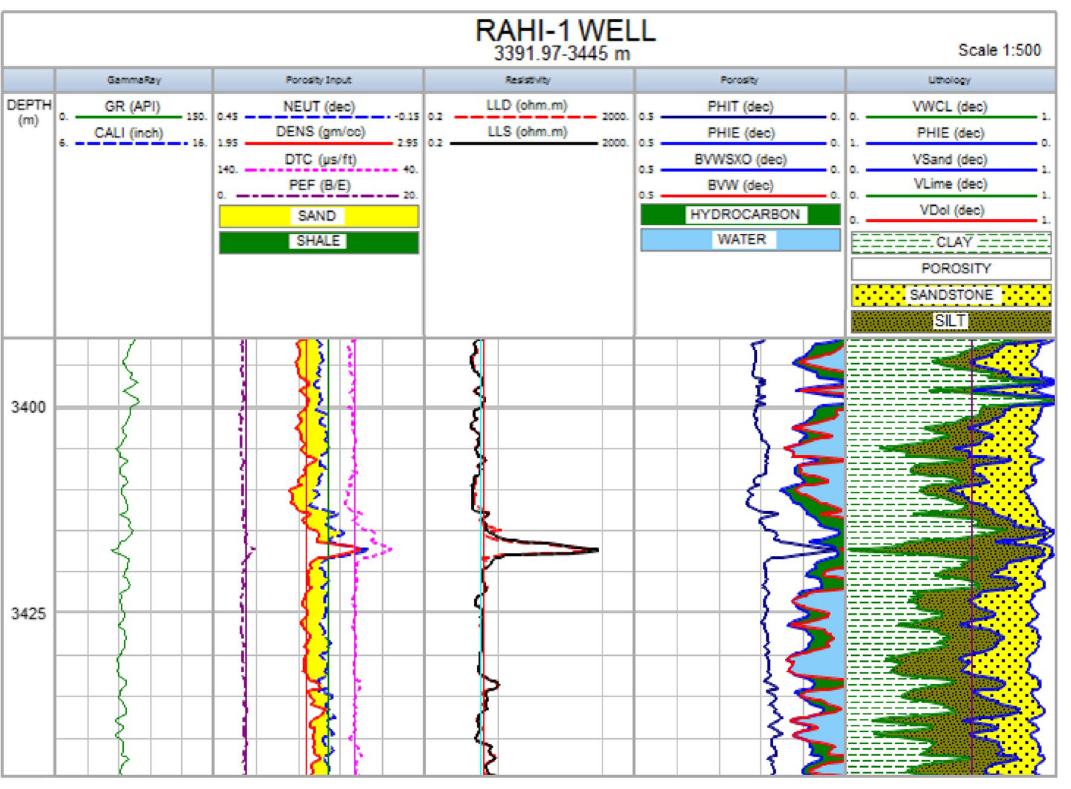
Fig. 13 Rahi-1 Well log interpretation shows no promising pay zones, and the Farewell Formation under study is water-bearing with low resis- tivity